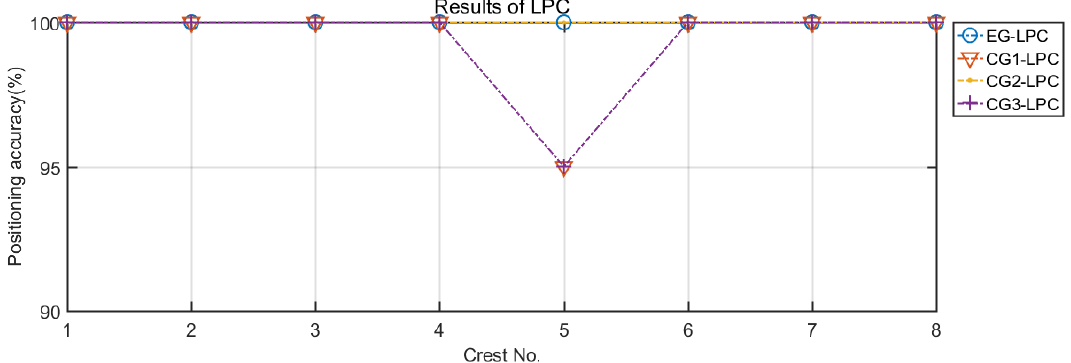
Figure 11. Load-position classifier results.